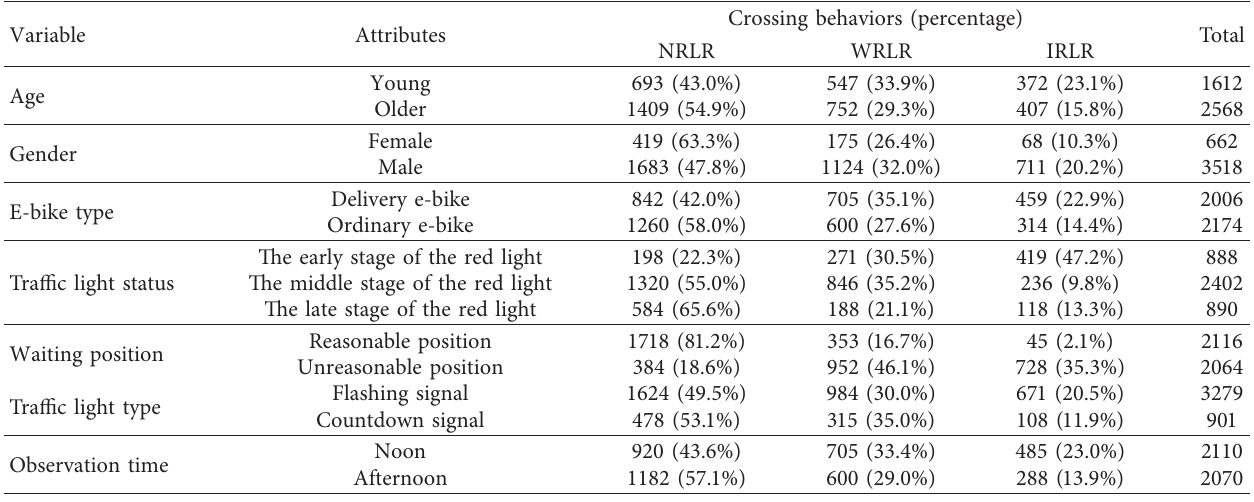
Table 2: Descriptive statistics of explanatory